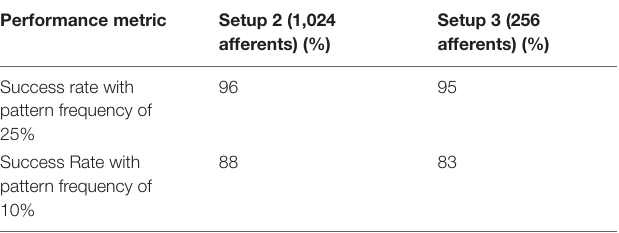
TABLE 3 | Results of adaptive STDP learning for setups 2 and 3.